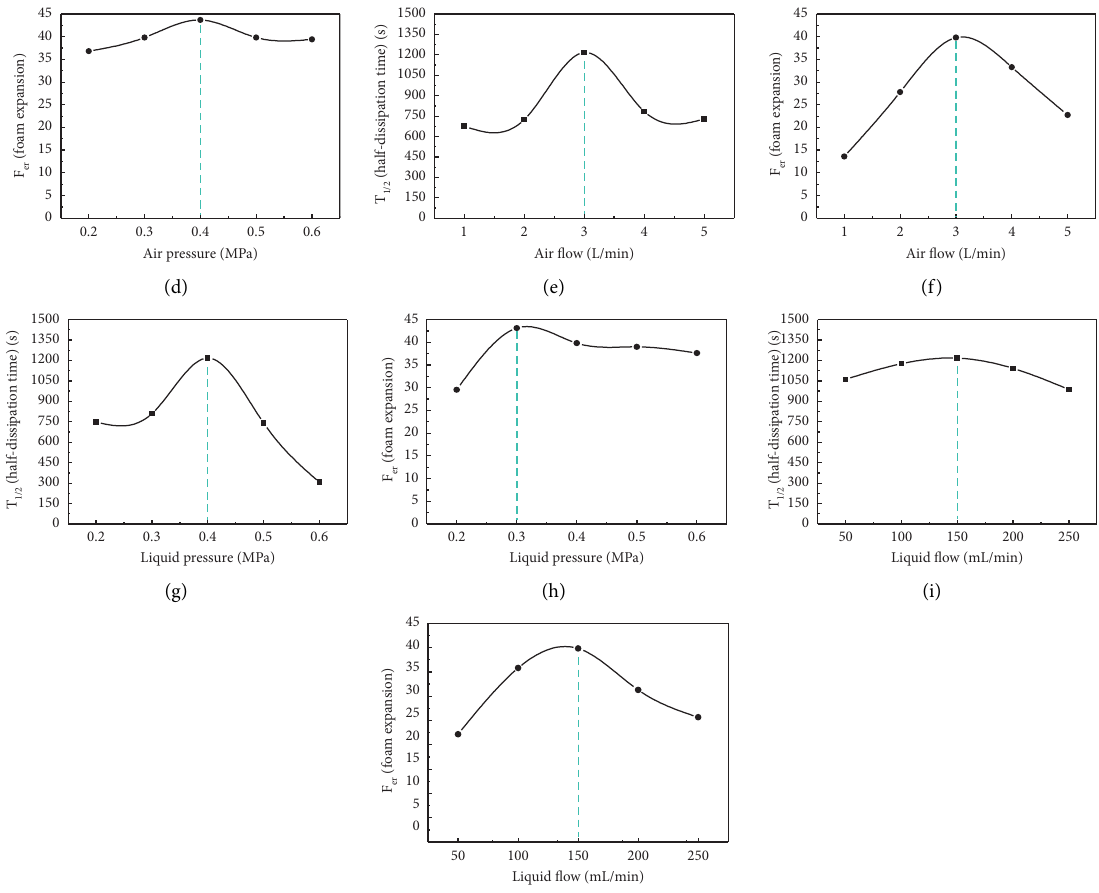
Figure 13: Effect of foaming parameters on foam properties.